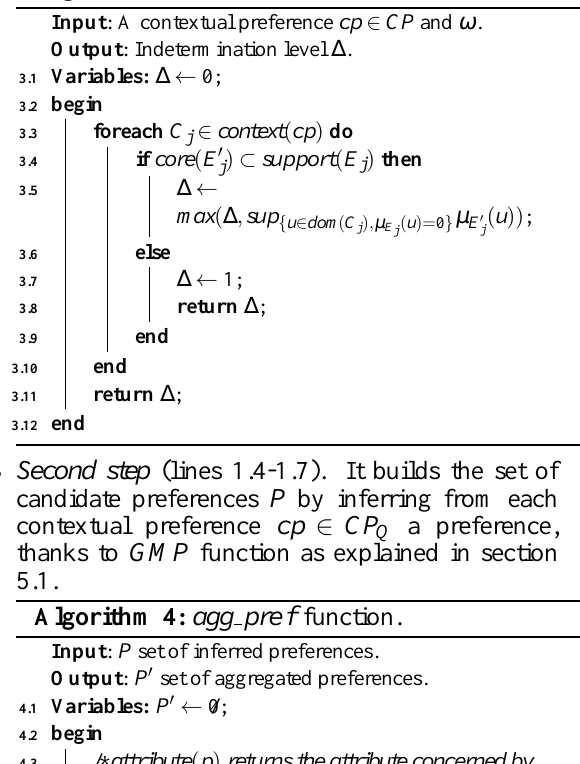
Algorithm 3: Delta function.